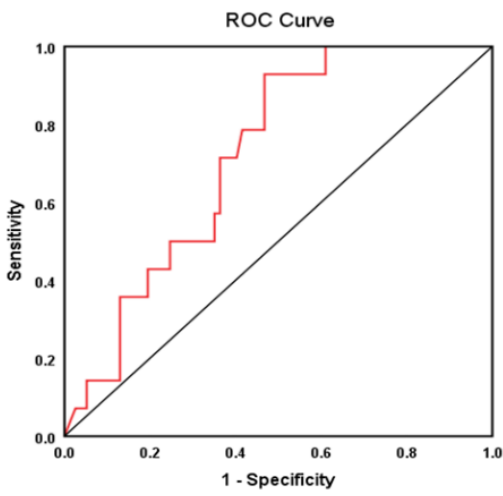
Figure 2 . NT-proBNP as a predictor of all-cause mortality at 12 months from the first episode of HFpEF. ROC = Receiver Operating